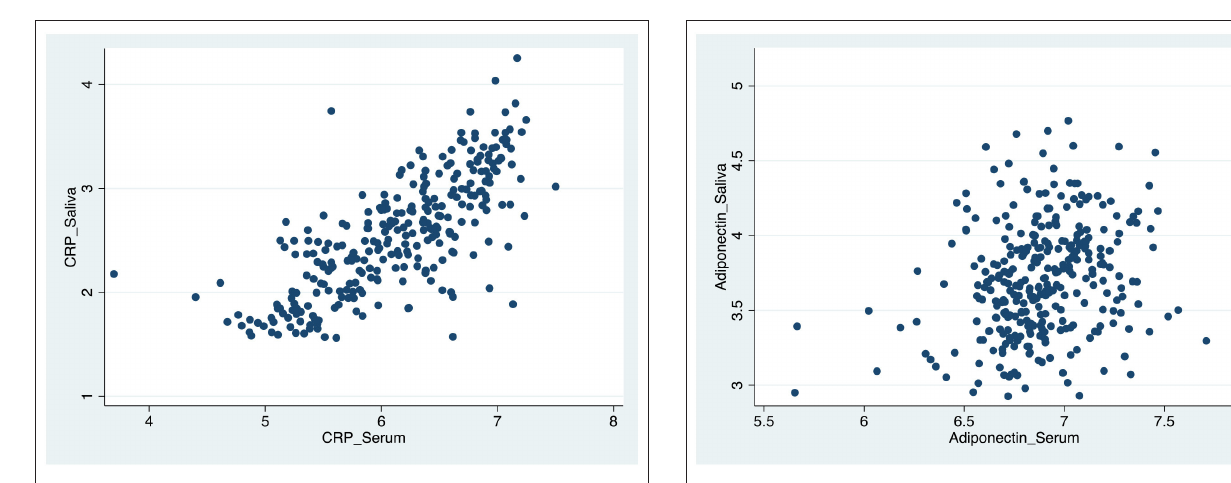
FIGURE 1 | Scatter plot of the correlation between serum and salivary CRP biomarker levels.